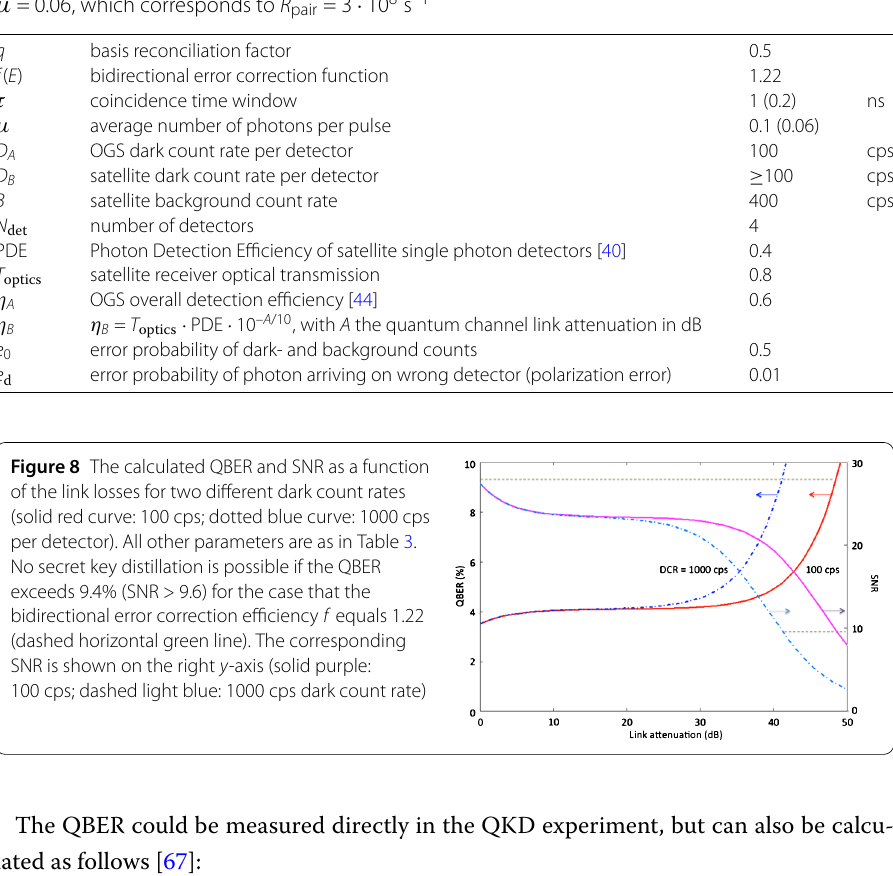
Table 3 Parameters of the QKD model for a conservative source performance. Note that we consider two cases: τ = 1 ns and μ = 0.1, corresponding to a pair production of 10 8 s –1 , and τ = 200 ps and μ = 0.06, which corresponds to R pair = 3 · 10 8 s –1